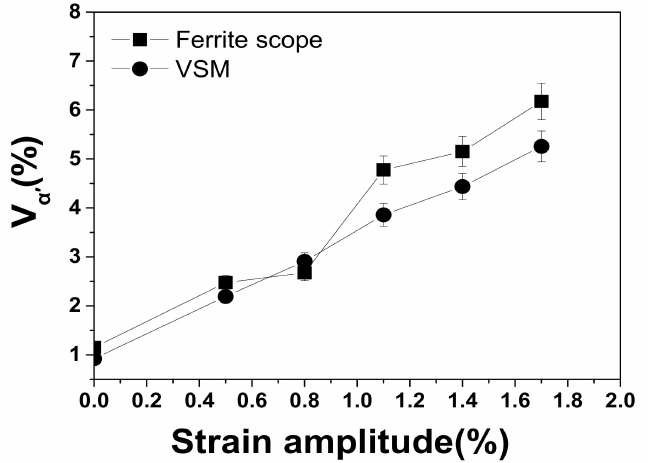
Figure 7. Variation in the volume fraction of α (cid:48) -martensite measured by ferrite scope and VSM in fatigue-failed specimens after exposure of the material to various strain amplitudes. The volume fraction of α (cid:48) -martensite increased linearly with the fatigue strain amplitude.